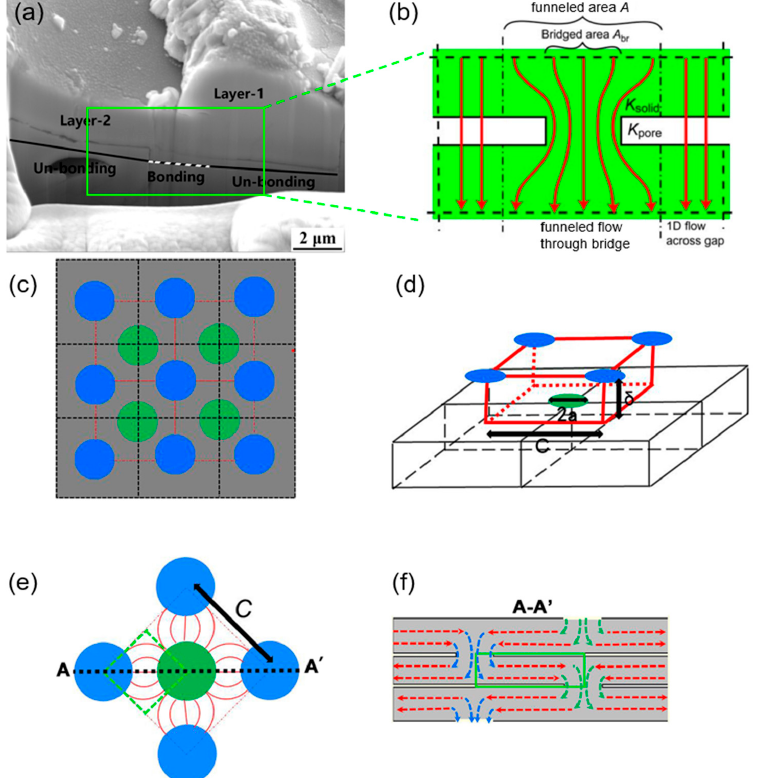
Figure 11. ( a ) Partially bonded layers of a plasma-sprayed coating prepared by focused ion beam ( b ) schematic representation of the “two flux regimes” model for heat flow through a set of plates connected via bridges. Analytical model to investigate the dominant effect of 2D pores on the prevention of heat flux: stacking of unit splat segments ( c ) top view ( d ) perspective view ( e ) top view of a basic stacking pattern ( f ) cross-section of A-A (cid:48) corresponding to ( e ).